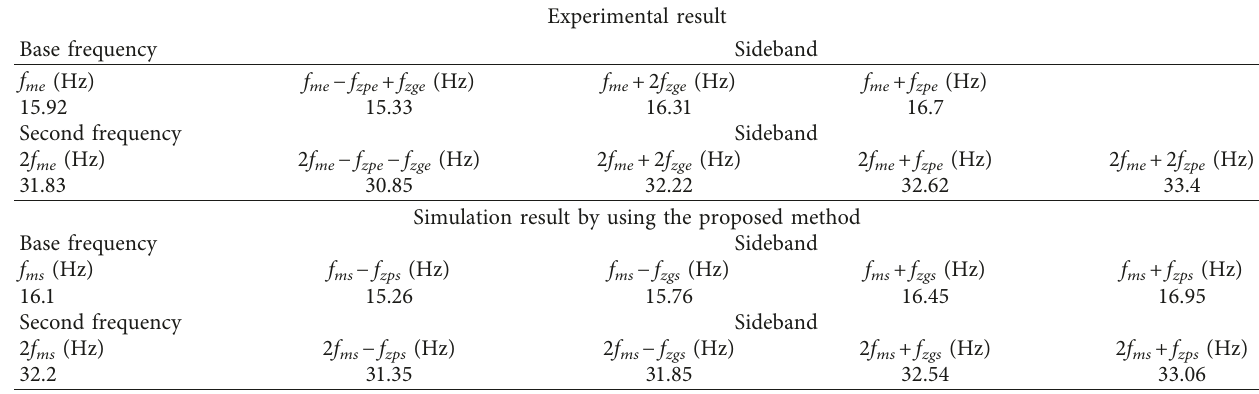
Table 5: Sidebands in experimental and simulation results at 50.8rpm.